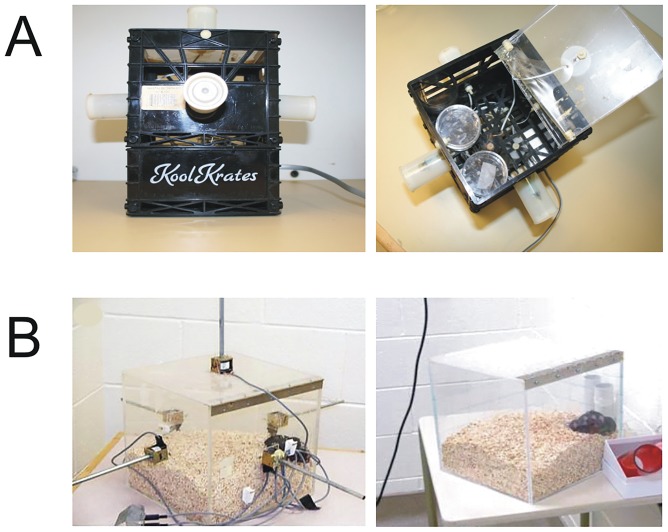
Diagram of the EMF exposure apparatus.A. In vitro exposure device is 12 cm on each side and fitted with 6 solenoids, one on each face of the cube, which are all activated during Thomas-EMF exposures. Plates containing cells are placed inside the cube for exposure. For the sham condition, the cells are placed in the box but electrical pulses are not sent to the solenoids. B. In vivo exposure device is 30 cm on each side and fitted with 6 solenoids, one on each face of the cube, and all solenoids are activated during Thomas-EMF exposure. The control box is not fitted with solenoids. A group of 5 mice is placed in the box for the exposure period.